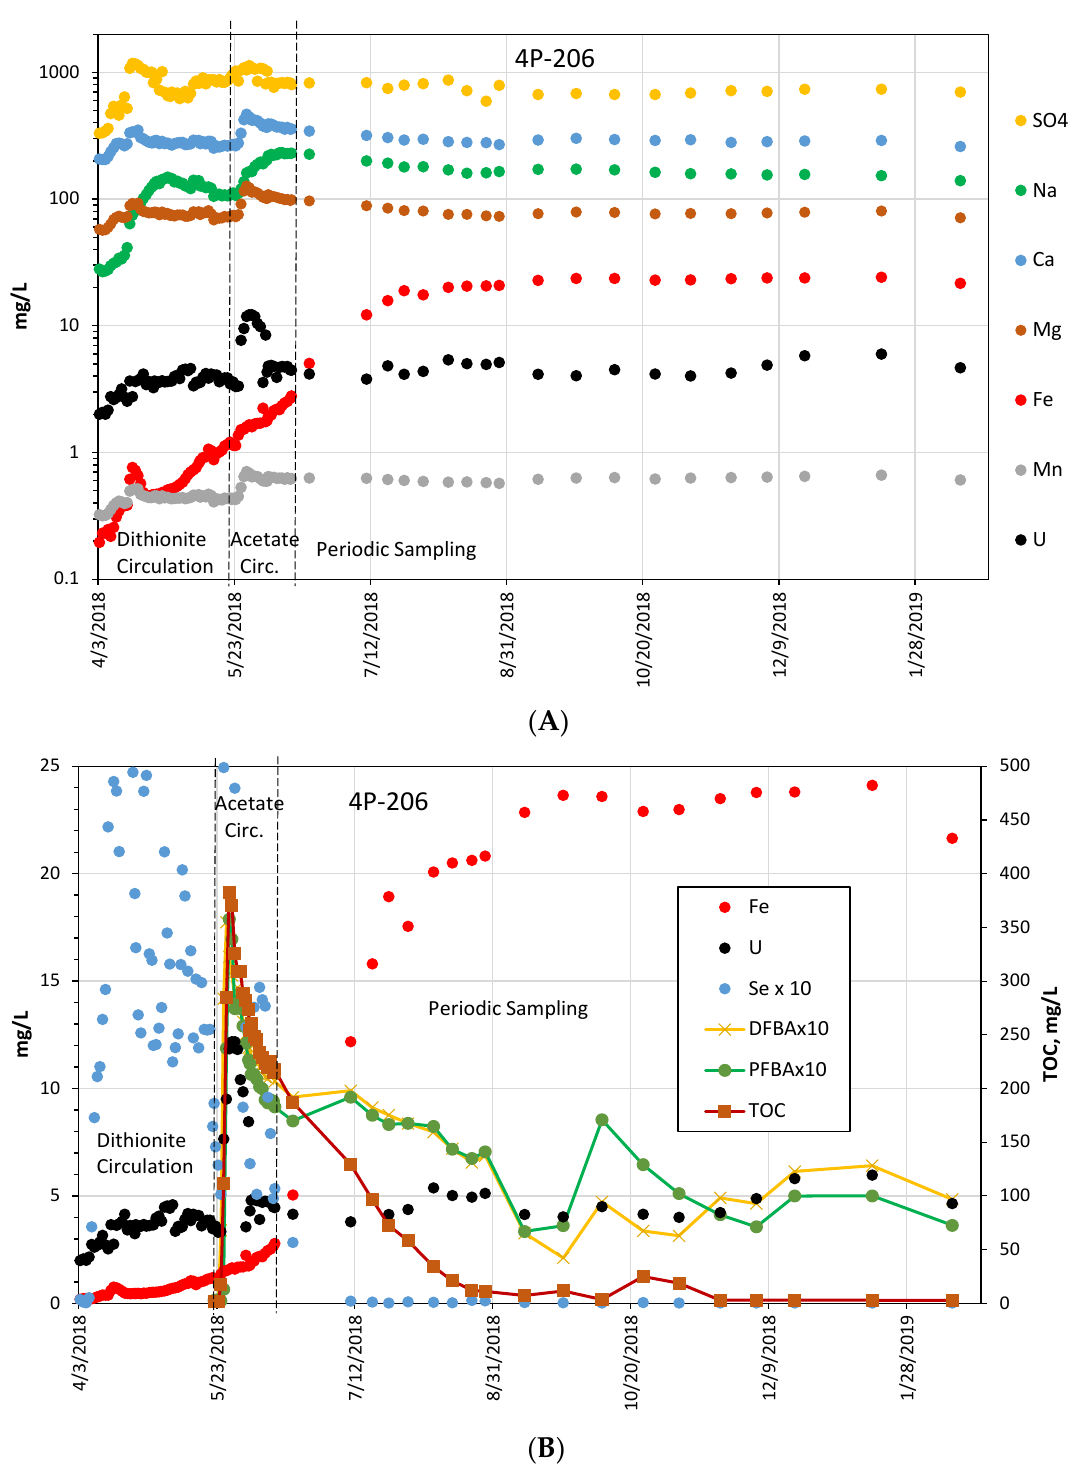
Figure A21. Breakthrough curves of tracers in well 4P-206 in fall 2017 and of difluorobenzoate after the acetate addition. Note that fall 2017 tracer concentrations are the sum of the 4 tracers arriving in 4P-206 divided by 6 (the number of injection wells used in the acetate test). The higher tail of the DFBA w/acetate curve is attributed to the recirculation of the tracer in the amendment test, whereas the tracers were diverted to a surface facility and not recirculated in the 2017 tracer test.